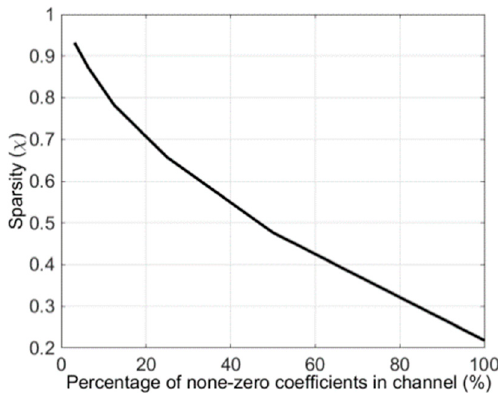
χ Figure 1. Sparsity ( ) vs. the percentage of none zero coefficients in the channel impulse response. Figure 1. Sparsity ( χ ) vs. the percentage of none zero coefficients in the channel impulse